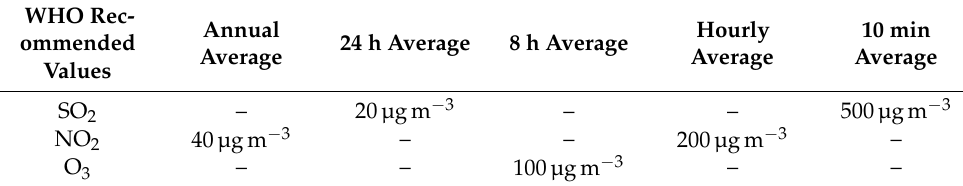
Table 2. Maximum concentrations of SO 2 , NO 2 , and O 3 recommended by the WHO. WHO Rec- Annual ommended Values